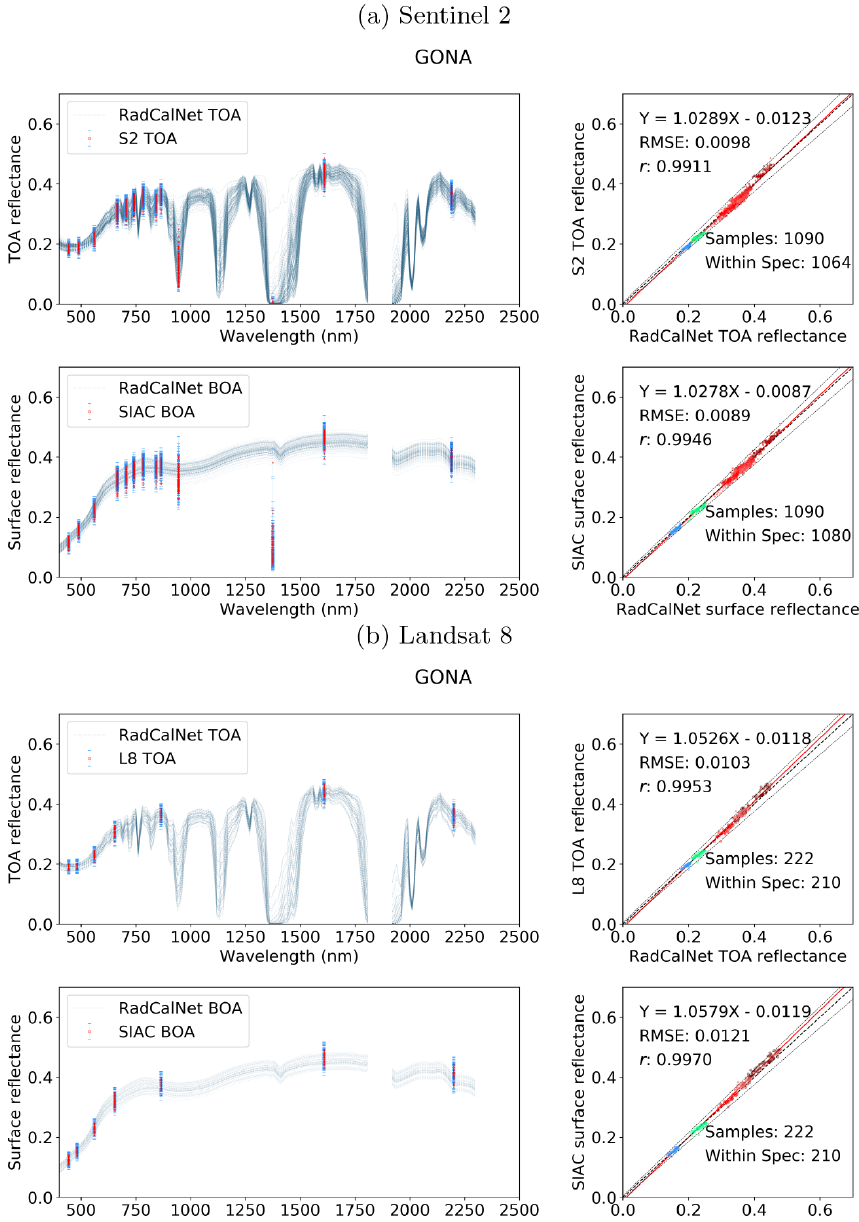
Figure 11. Comparison between the S2 (a) and L8 (b) TOA reflectance and RadCalNet simulated nadir-view TOA reflectance (top row), and the surface reflectance after correction against RadCalNet nadir-view surface reflectance (bottom row) at Gobabeb. The blue lines on the left are different spectra measurements from RadCalNet, and the red dot with blue error bars (1 standard deviation) are the TOA or surface and TOA reflectance with uncertainty. The EE is defined as ± ( 0 . 05TOA(BOA) + 0 . 005 ) , denoted as black dashed lines in the scatter plots. The regression line is draw as a red line and the 1-to-1 reference line is drawn as a thick black dashed line in the